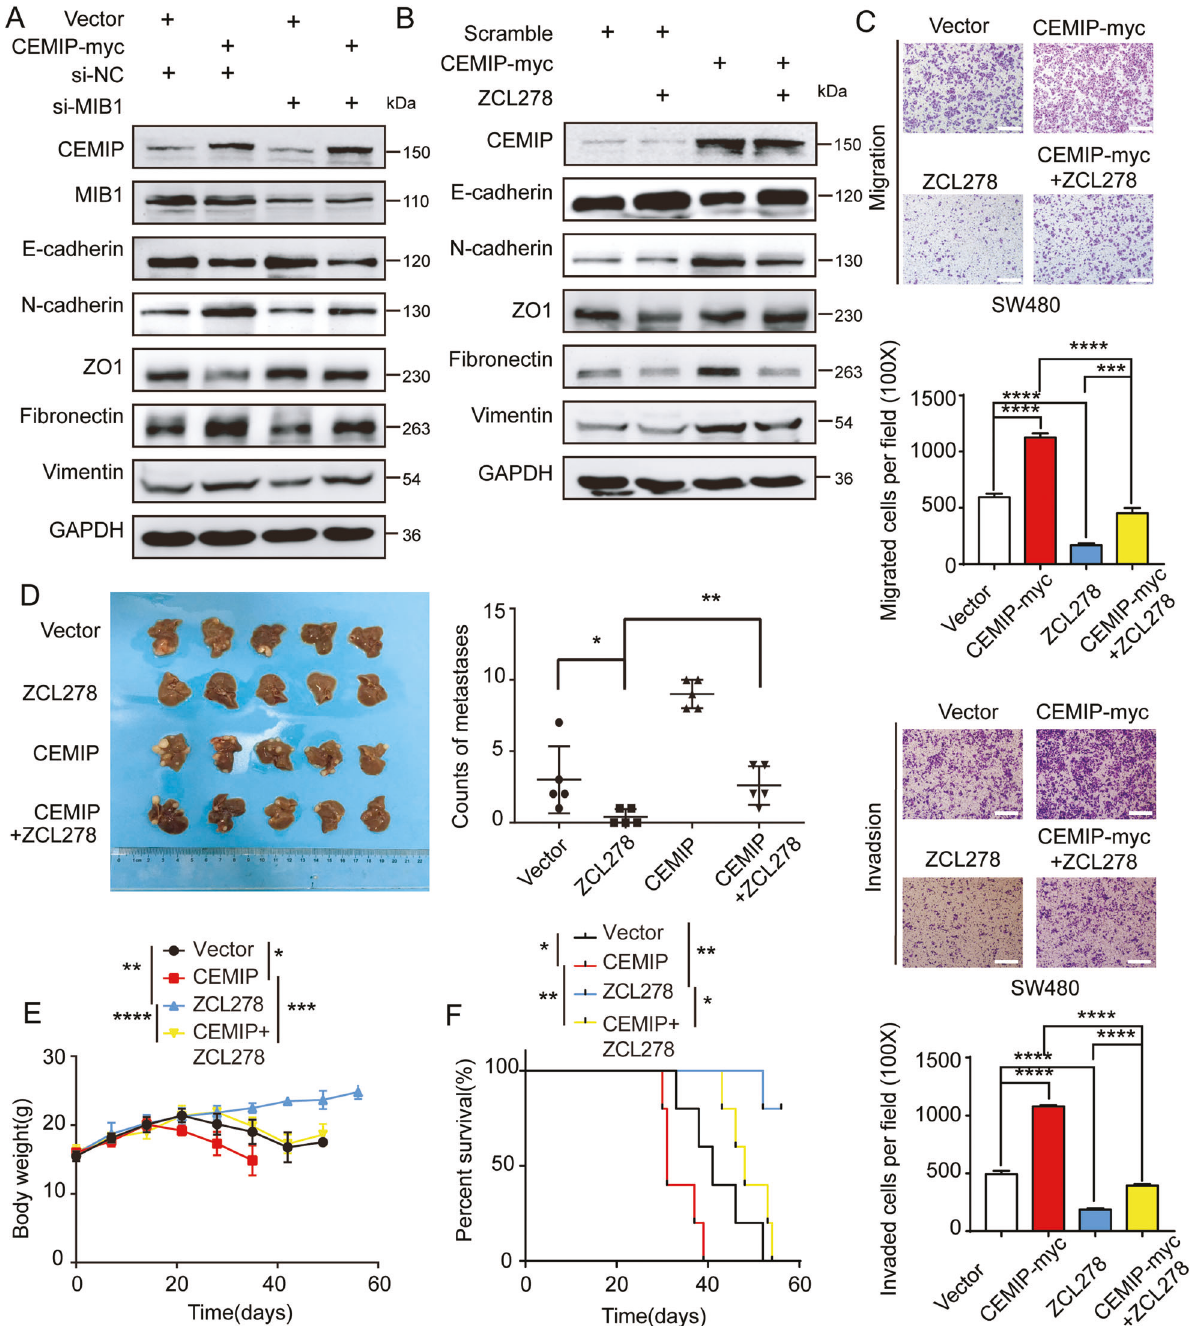
Fig. 6 CEMIP promotes metastasis of CRC cells through GRAF1/CDC42/MAPK pathway-regulated EMT. A Western blotting analysis of EMT associated proteins in SW480 cells transfected with the indicated constructs. B Western blotting analysis of EMT associated proteins in SW480 cells transfected with the indicated constructs. C Transwell chamber migration and invasion of SW480 cells transfected with the indicated constructs with or without ZCL278. *** P < 0.001; **** P < 0.0001. D Representative images of livers of BALB/c nude mice, treated with or without ZCL278. Numbers of liver metastases were detected in each group (day 28, n = 5), mice were treated with or without ZCL278. * P < 0.05; ** P < 0.01. E Body weight curves of mice treated with or without ZCL278. * P < 0.05; ** P < 0.01; *** P < 0.001; **** P < 0.0001. F Survival curves of mice treated with or without ZCL278. * P < 0.05; ** P <